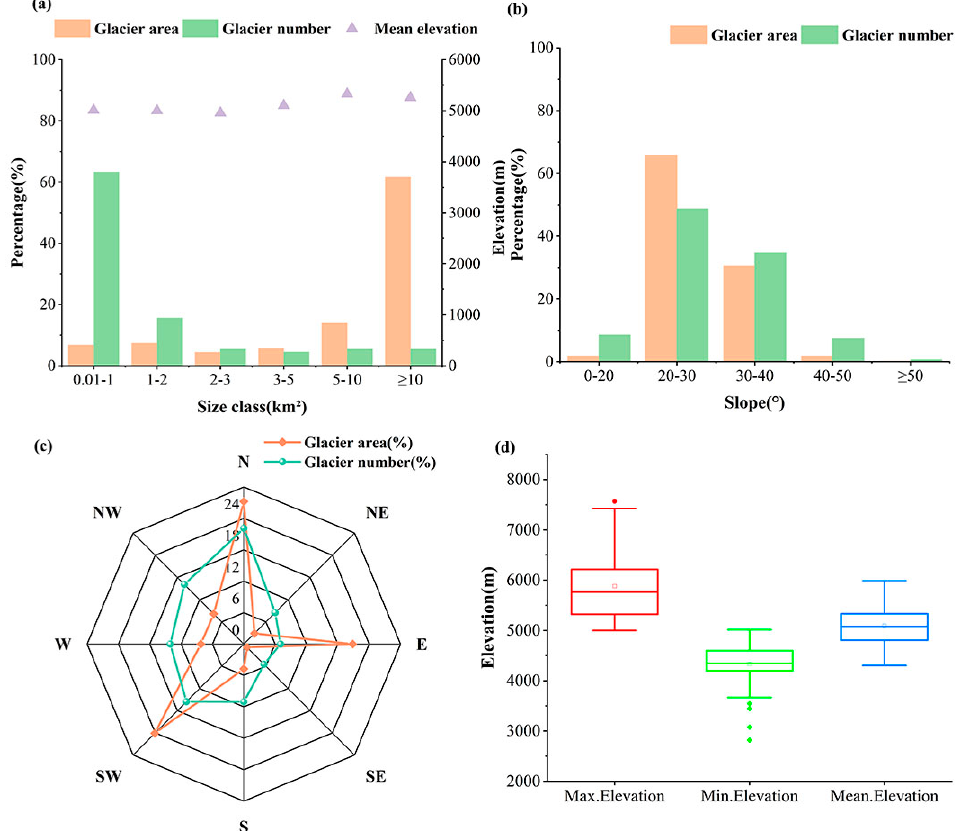
Figure 12. ( a ) Distribution of glacier number and area, and mean altitude for di ff erent size classes; ( b ) glacier number and area for di ff erent mean slopes; ( c ) glacier number and area for various aspects of the study area; and ( d ) boxplots of minimum, mean and maximum elevations of the